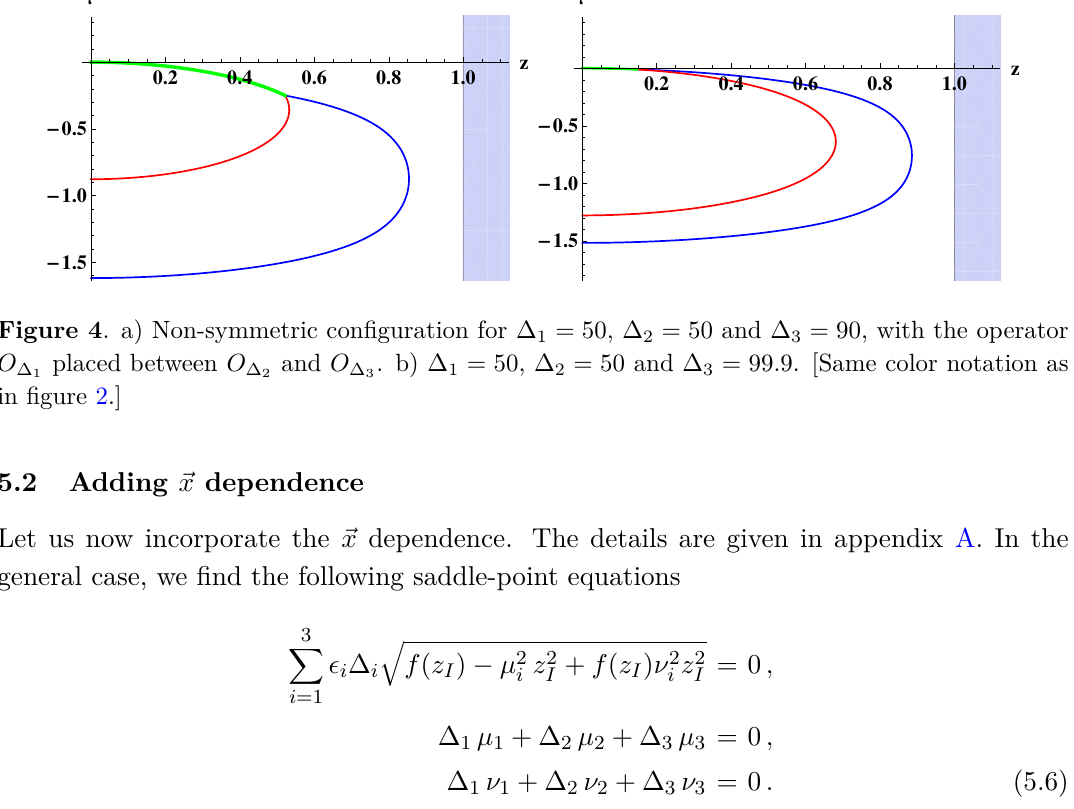
Figure 3 . a) Non-symmetric configuration for ∆ 1 = ∆ 2 = 30 and ∆ 3 = 40 , with the operator O ∆ placed between O ∆ and O ∆ . b) As ∆ 3 → ∆ 1 + ∆ 2 , the configuration reaches the factorization 1 2 limit. In the figure b), ∆ 1 = ∆ 2 = 30 and ∆ 3 = 59 . 9 . [Same color notation as in figure 2.]